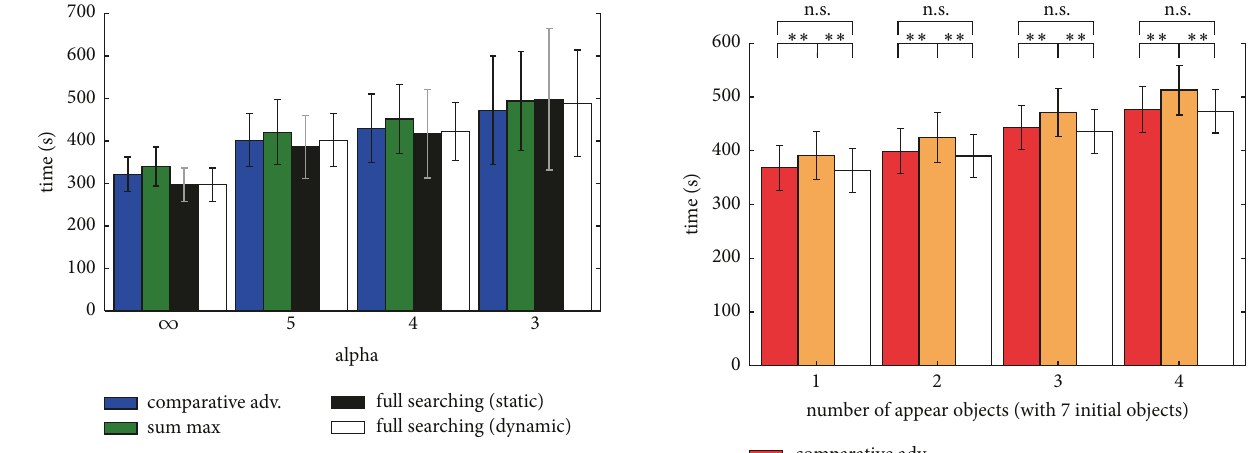
Figure 13: Makespan in the later condition.